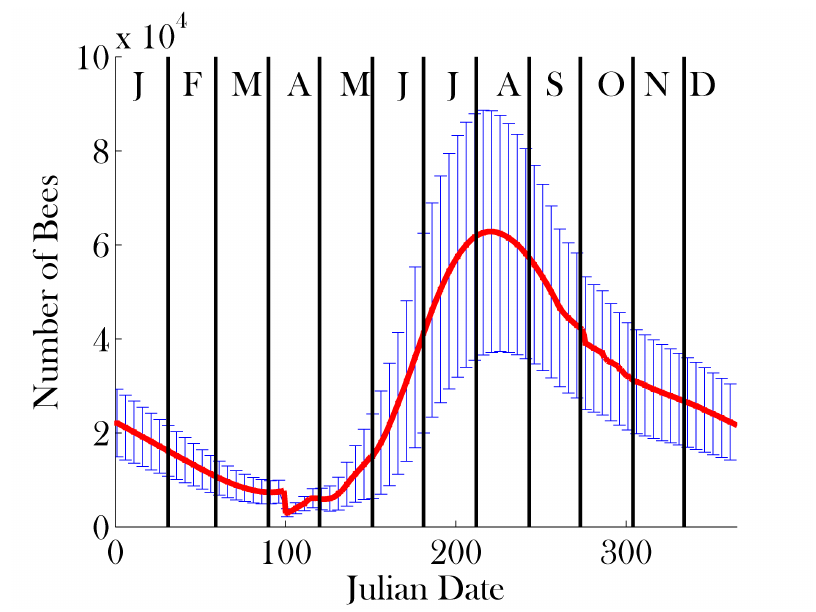
Figure 4. Results of sensitivity analysis on total colony size: mean (red line) ± one standard deviation (error bars). Parameter sets were sampled using Latin hypercube sampling [61] with 10 divisions from the mean values provided in Table 1, ranging ± 20%. The parameters on which sensitivity analysis was performed appear in bold in Table 1.